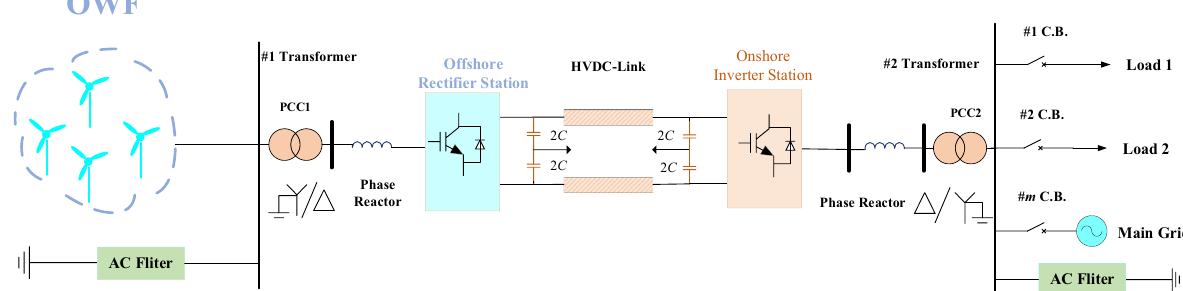
Fig. 8 Schematic diagram of offshore wind power plant grid integration via VSC-HVDC